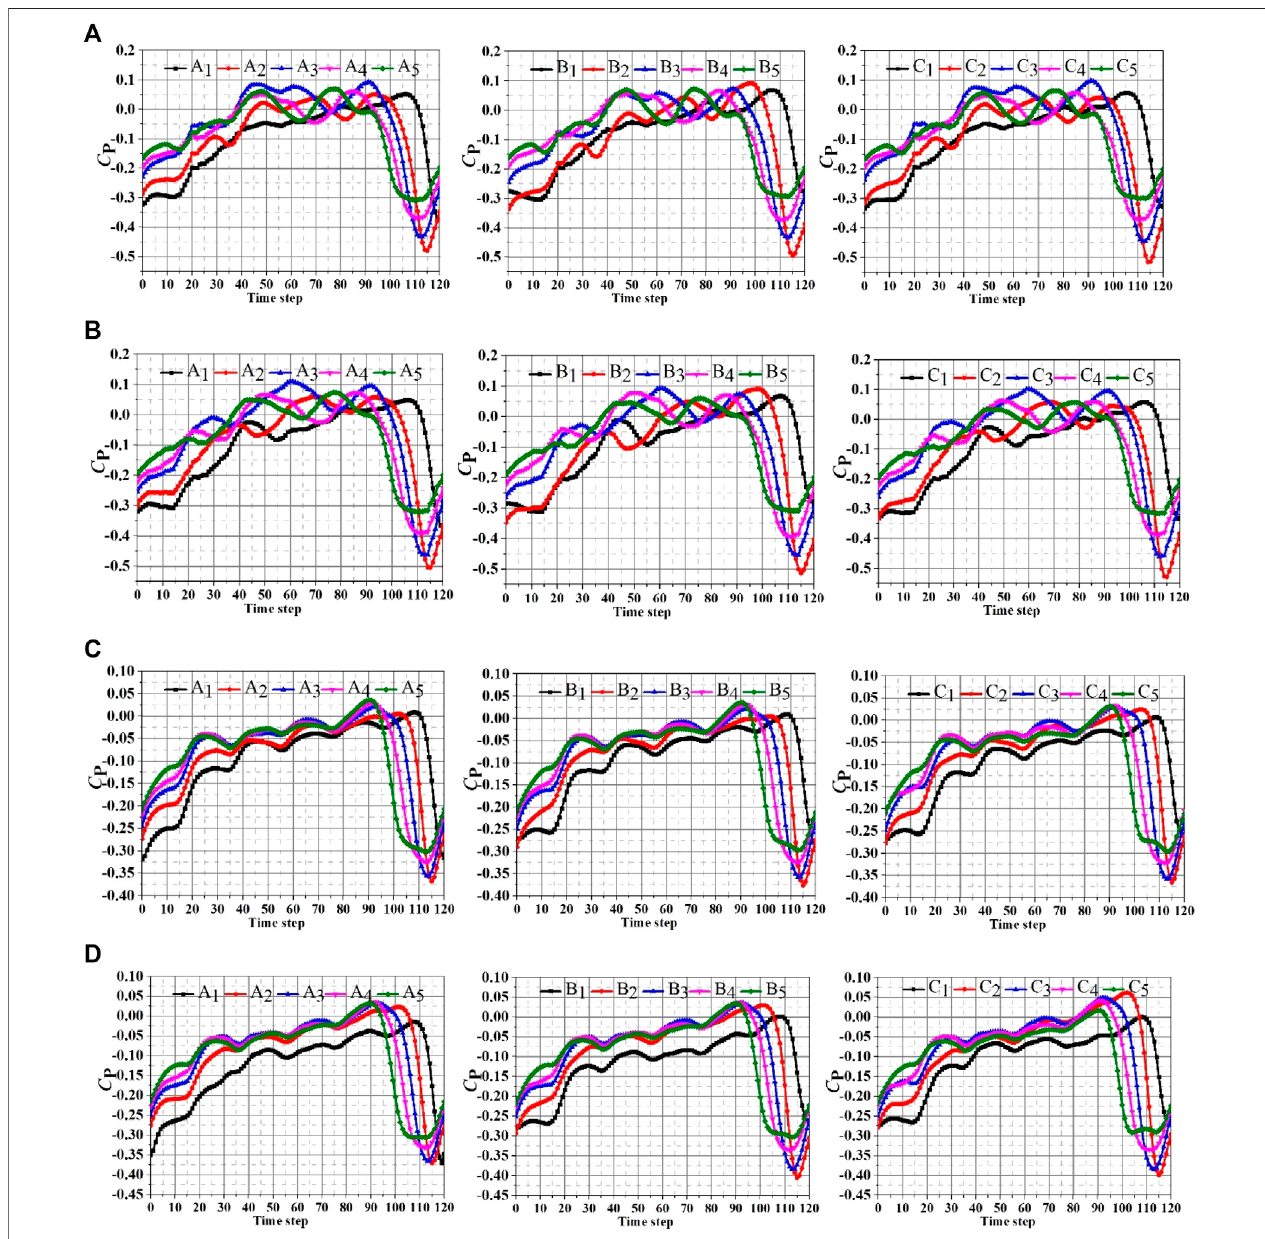
FIGURE7| Thepressure fl uctuations distribution ofdifferentschemes. (A) The pressurepulsationdistributionofscheme 1. (B) Thepressurepulsationdistribution of scheme 2. (C) The pressure pulsation distribution of scheme 3. (D) The pressure pulsation distribution of scheme 4.